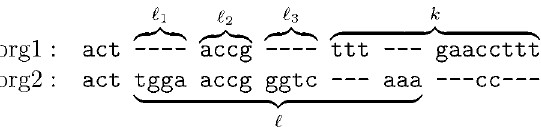
Figure 5. Joining Gaps into Unmatched Regions and Extracting Long Ones from a Sequence Alignment (Step 3 of the Preprocessing Phase) Gaps ‘ 1 and ‘ 3 in org1 are joined if the (intragapped) hit ‘ 2 is short enough. Assume that ‘ 2 and other intra-gapped regions are short enough so that the proximal gaps in org1 are joined to form the unmatched region ‘ . Assume that gaps in org2 are joined similarly to form the unmatched region k, and that the unmatched regions ‘ and k are long enough. If the regions ‘ and k intersect (as in this example), they are joined and the resulting segments in both organisms are extracted to be handled in the next step.